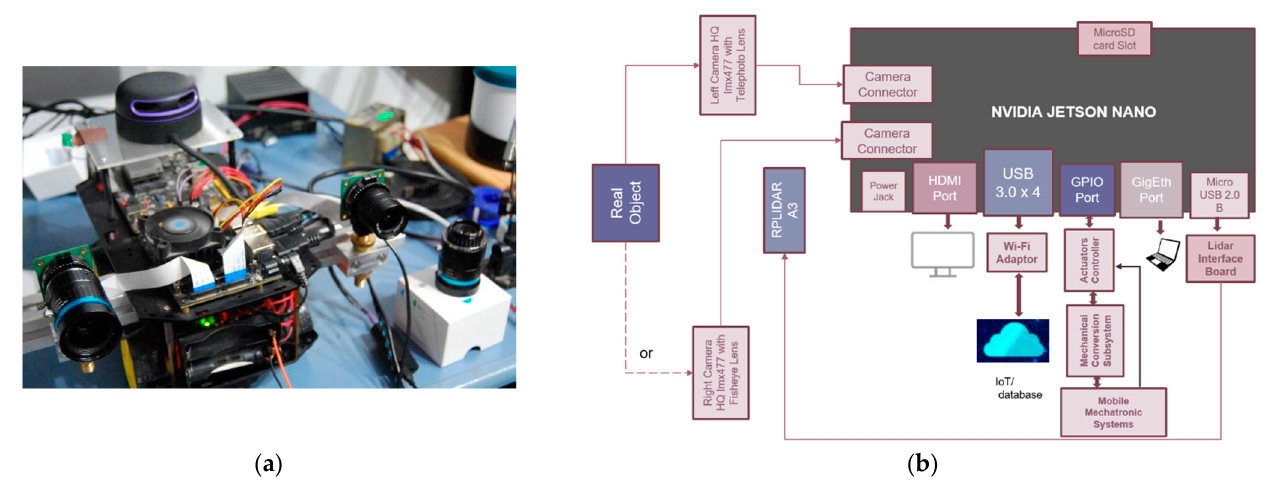
Figure 7. Mobile robotic platform. ( a ) Overview; ( b ) hardware platform block diagram.